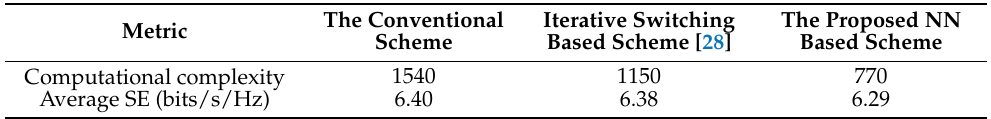
Table 2. Complexity and average spectral efficiency of the proposed NN based scheme comparable to the conventional scheme and iterative switching based